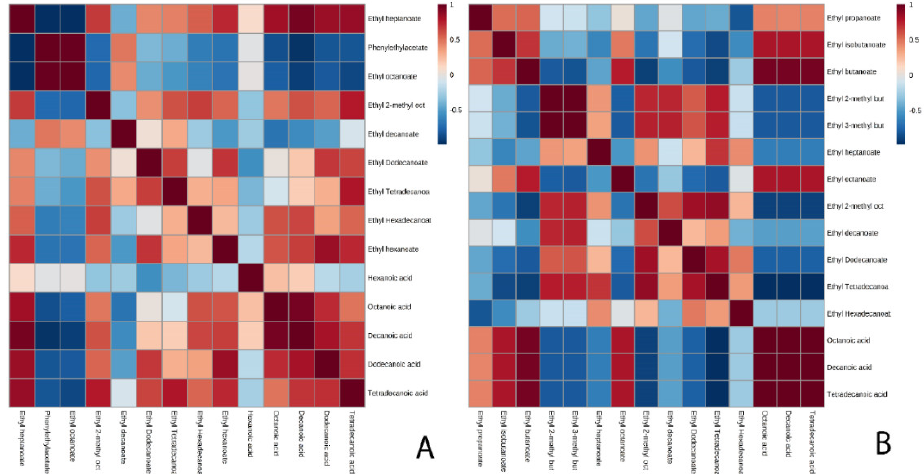
Figure 5. Matrix of correlations established between esters and fatty acids in the condition without CO 2 overpressure for flor yeast ( A ) and the P29 strain ( B ).